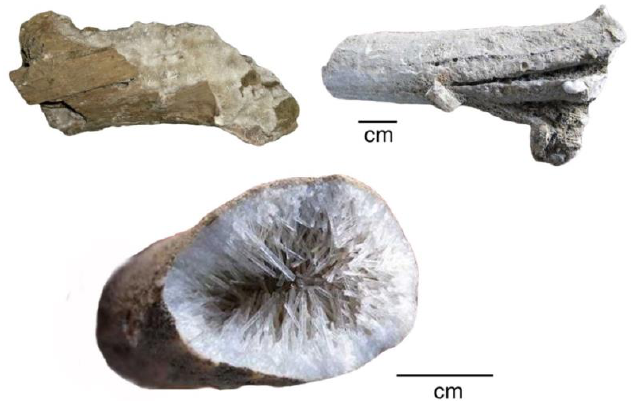
Figure 30. Wood mineralized with calcite and natrolite, Mount Elgon, Uganda, Miocene age. Photos courtesy of Mike Viney, used with permission.